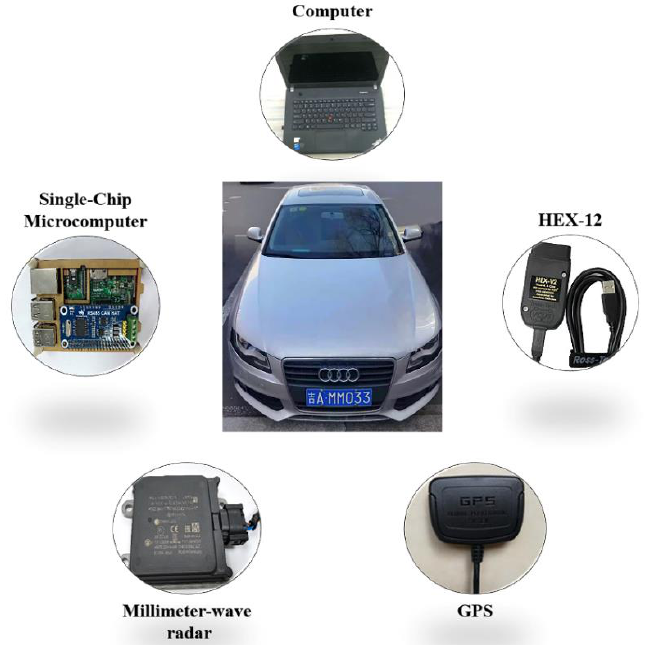
Figure 5. Experimental equipment.